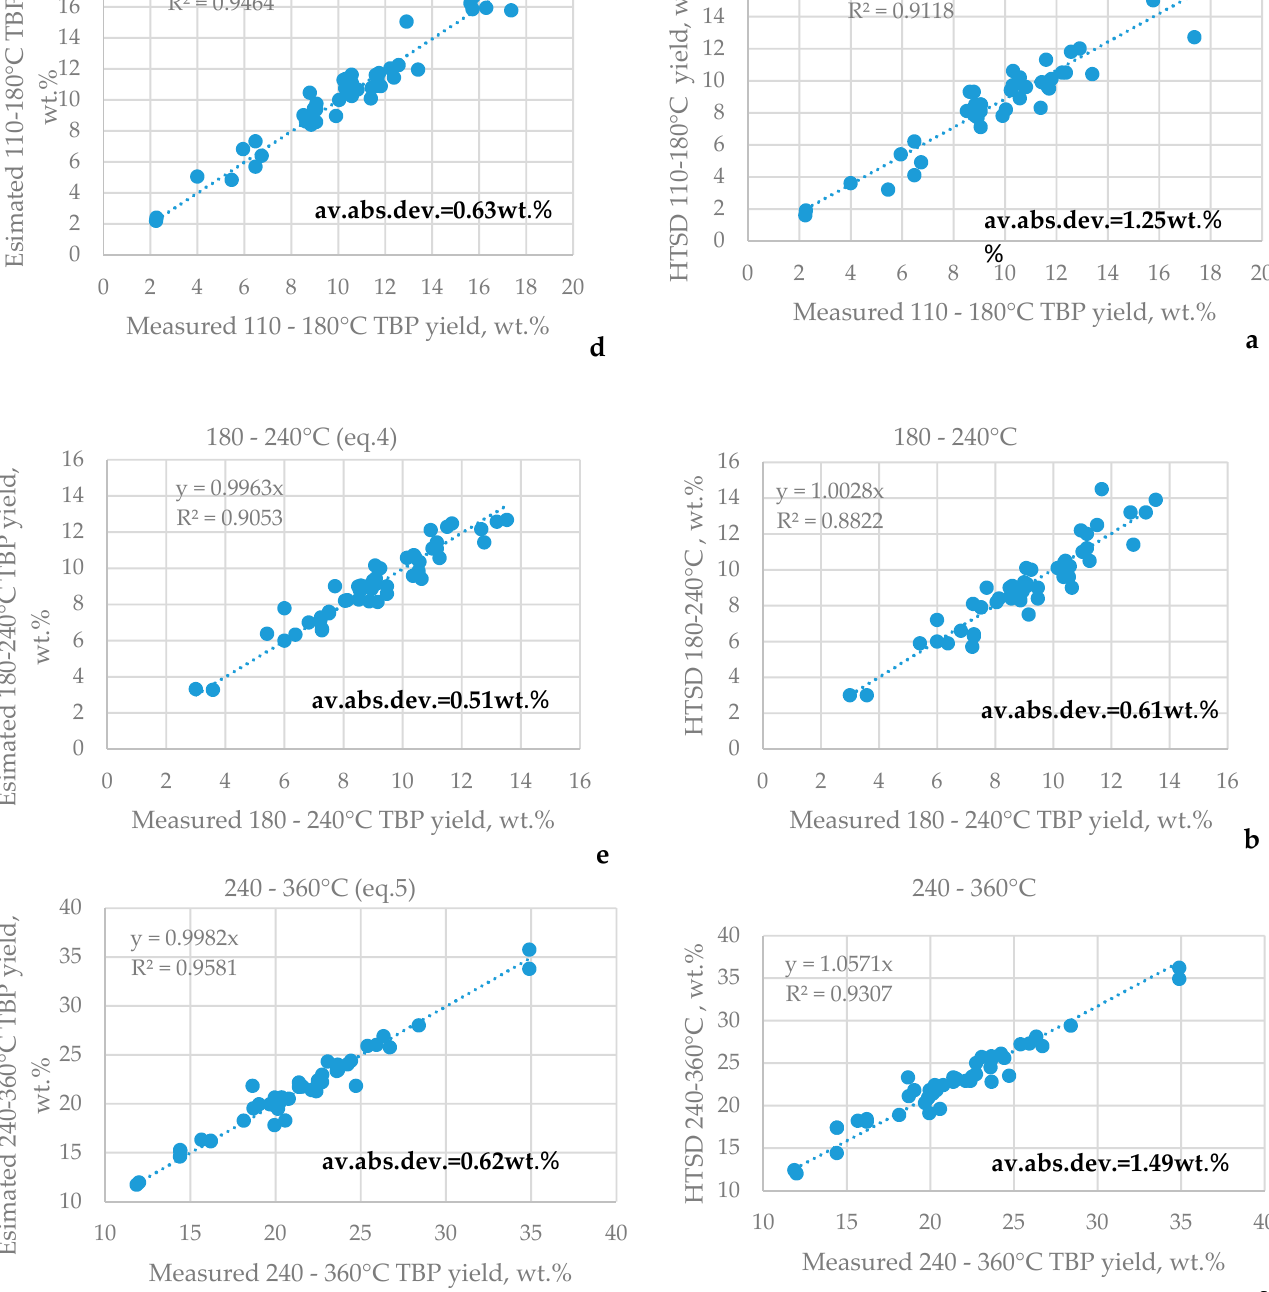
Figure 2. Juxtaposition of the TBP with HTSD yields of the 110–180 °C ( a ), 180–240 °C ( b ), and 240–360 °C ( c ) fractions; the estimated TBP yields according to Equation (3) ( d ), Equation (4) ( e ), and Equation (5) ( f ).